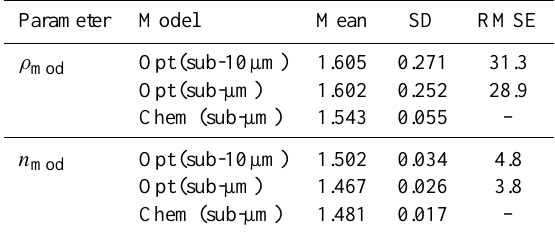
Table 2a. Mean and standard deviation (SD) of the retrieved effec- tive density ( ρ mod ) and real refractive index ( n mod ) obtained for all retrievals under wet and dry conditions (237 points). The RH is 58.4 ± 8.1 (mean ± SD). The chemically derived aerosol properties represent dry conditions only. The corresponding root mean squared error (RMSE) is defined as the root mean squared difference (%) between the aerosol characteristics retrieved from the measured op- tical properties and their counterparts calculated from the chemical composition data. These basic statistics (mean, SD, and RMSE) rep- resent both the sub-µm and sub-10µm aerosol characteristics. As discussed in Barnard et al. (2010), uncertainties in the chemically derived density and refractive index are at least 5%.